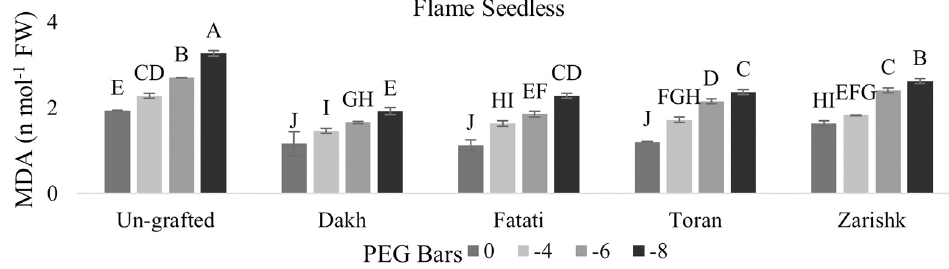
Fig 4. Malonaldehyde content (MDA) of un-grafted and grafted Flame Seedless scion variety on different wild grapevines under drought stress condition. Data is represented as mean SD and letters showed significant difference at p <